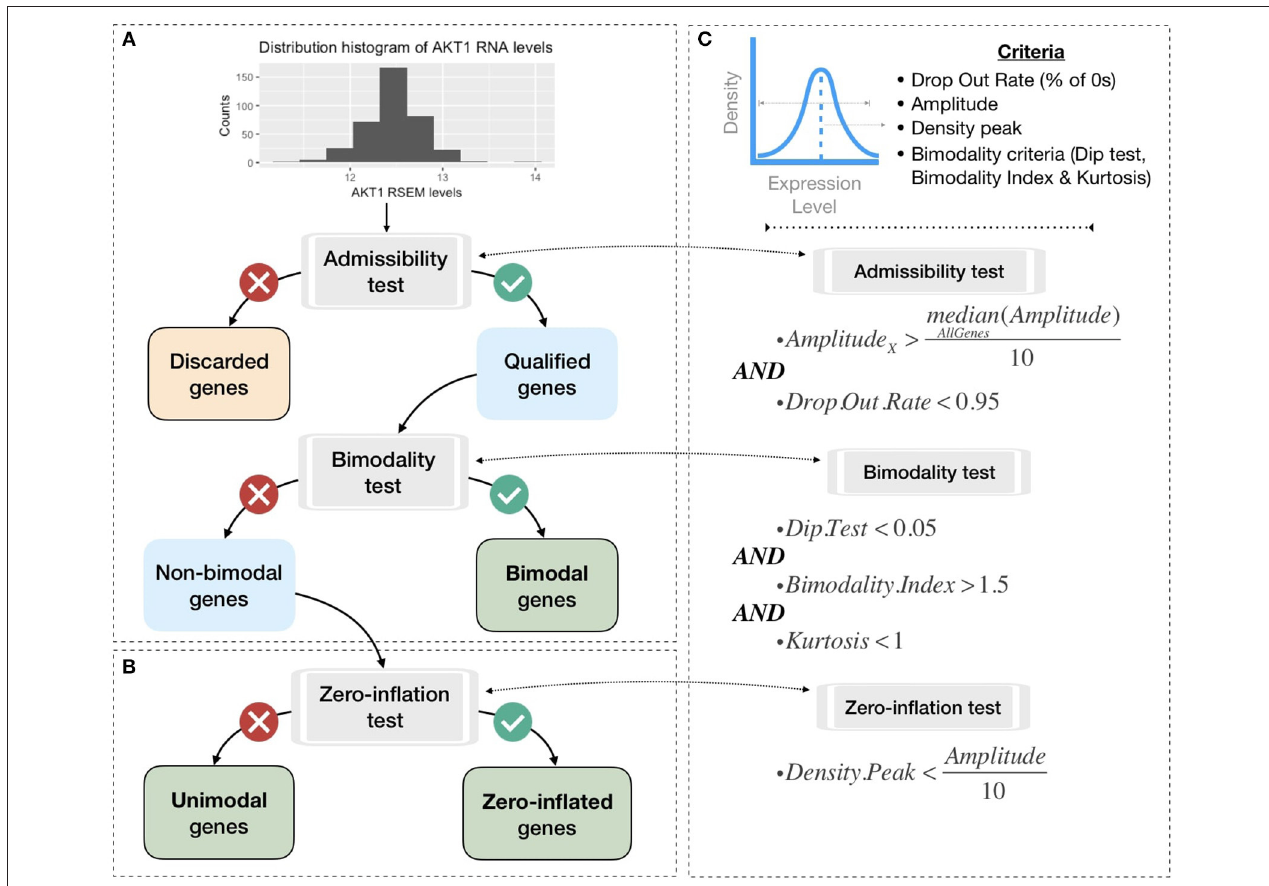
FIGURE 3 | Processing pipeline to classify genes in different categories based on their expression pattern across the cohort. (A) Tests to separate bimodal from non-bimodal genes before subsequent binarization. (B) Test to classify non-bimodal genes in unimodal or zero-inflated genes. (C) Statistical and logical content of the various tests used in (A,B) , thresholds have been taken from the papers presenting each tool and are more precisely justified in the Methods